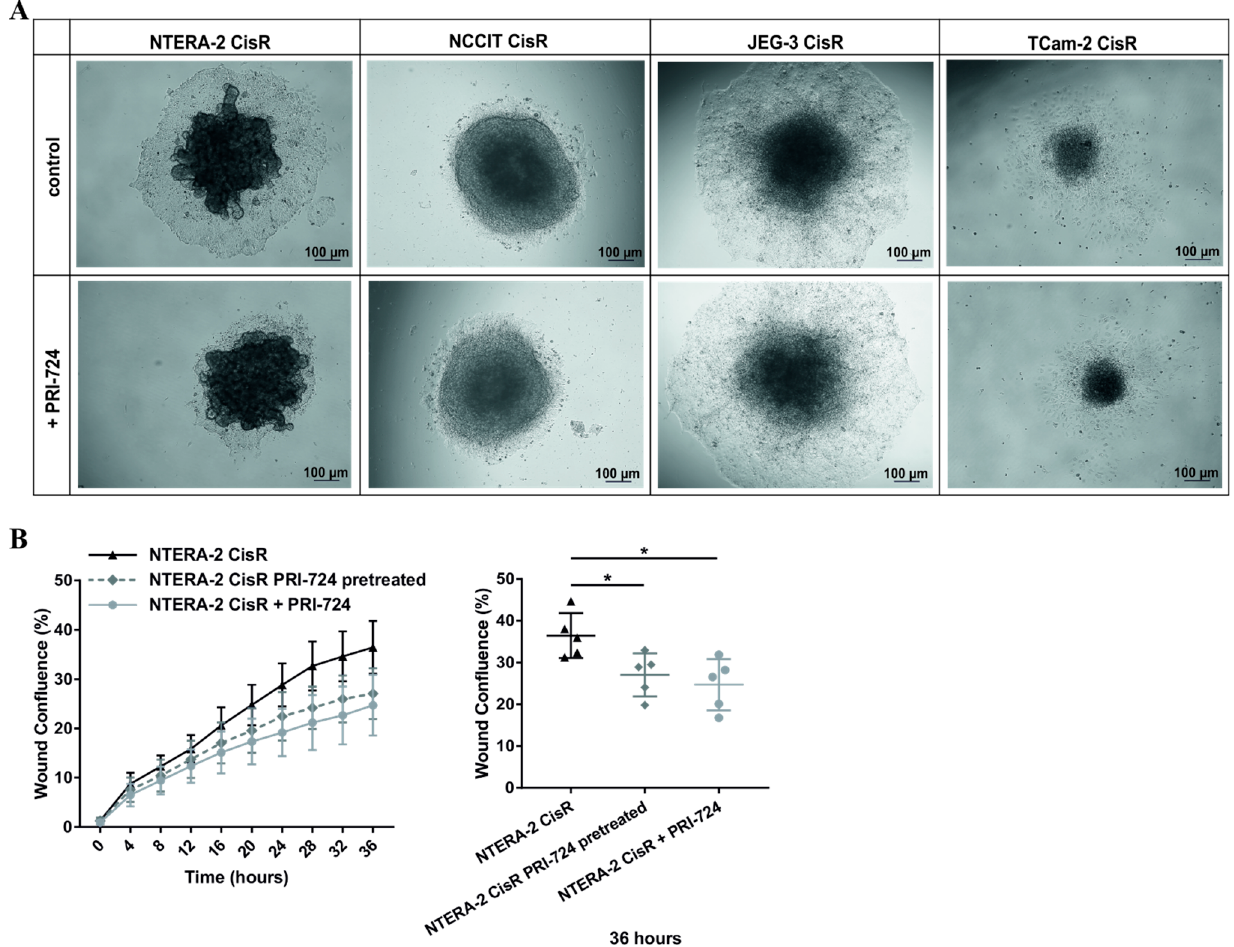
Figure 7. PRI-724 significantly inhibited migratory capacity of NTERA-2 CisR cells. ( A ) PRI-724 significantly decreased the migration of NTERA-2 CisR cells out of the 3D spheroid. Migratory capacity of other GCT cell lines was not affected by PRI-724 treatment. Images were taken 3 days post transfer from non-adherent to adherent conditions. ( B ) Migration of NTERA-2 CisR cells pretreated (for 72 h before plating) or treated (for 36 h) with PRI-724 was significantly decreased compared to untreated NTERA-2 CisR cells in a wound healing assay. Confluent monolayers of NTERA-2 CisR cells were wounded and cell migration was observed by live-cell imaging for 36 h. * p < 0.05.